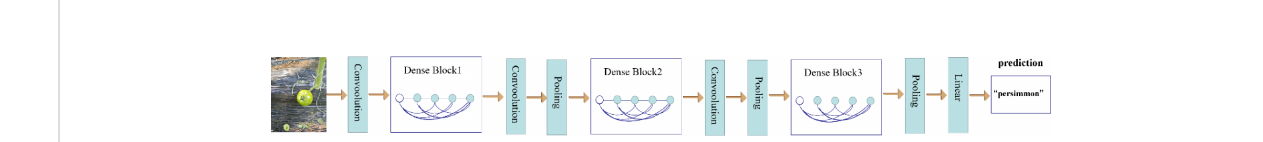
FIGURE 3 DenseNet structure diagram (including three dense block blocks, three convolution and pooling